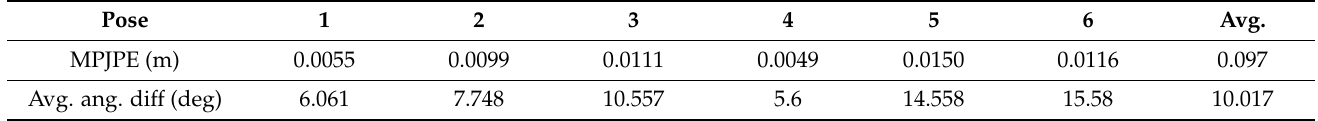
Table 2. MPJPE and average angular difference values for the best-fitted poses in Figure